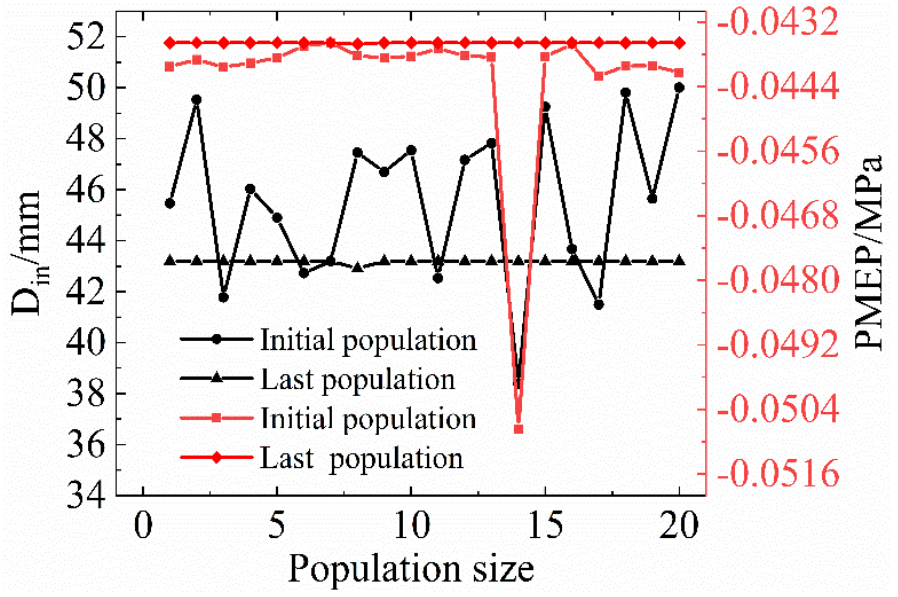
Figure 13. Distribution map of the initial population and the last population.